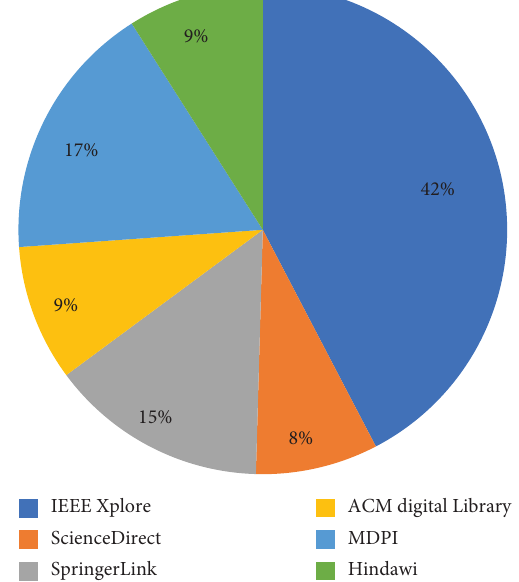
Figure 5: Publisher-wise percentage of the papers reviewed in this